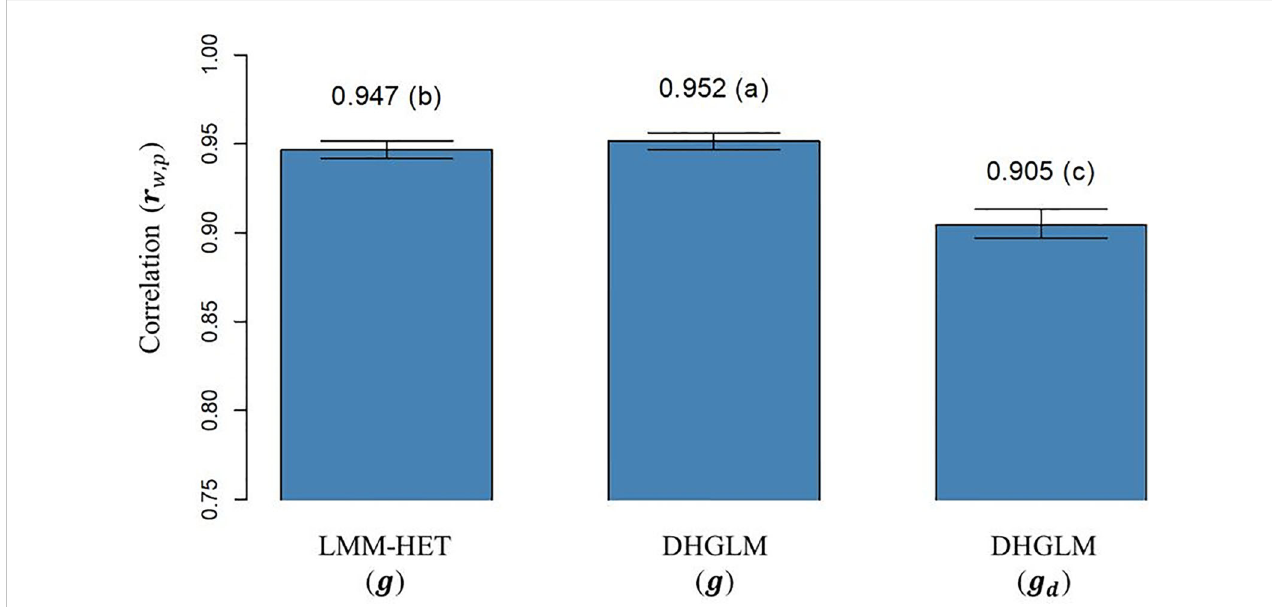
FIGURE 5 Correlation between predicted additive genetic values obtained with whole phenotypic information and additive values obtained with partial phenotypic information ( r w , p ) in a leave-one-line-out (LOO) cross-validation. LMM-HET: linear mixed model allowing heteroscedasticity of residual variance for the different environments. DHGLM: double hierarchical generalized linear model. g : predicted additive genetic values for corrected phenotypes ( y c ). g d : predicted additive genetic values for dispersion variable ( y d ). Black bars represent the 95% con fi dence interval (CI) computed for each estimate as the standard deviation of the estimate multiplied by 1.96. The letter above the bar denotes signi fi cant differences between models in a t-test ( P-value <